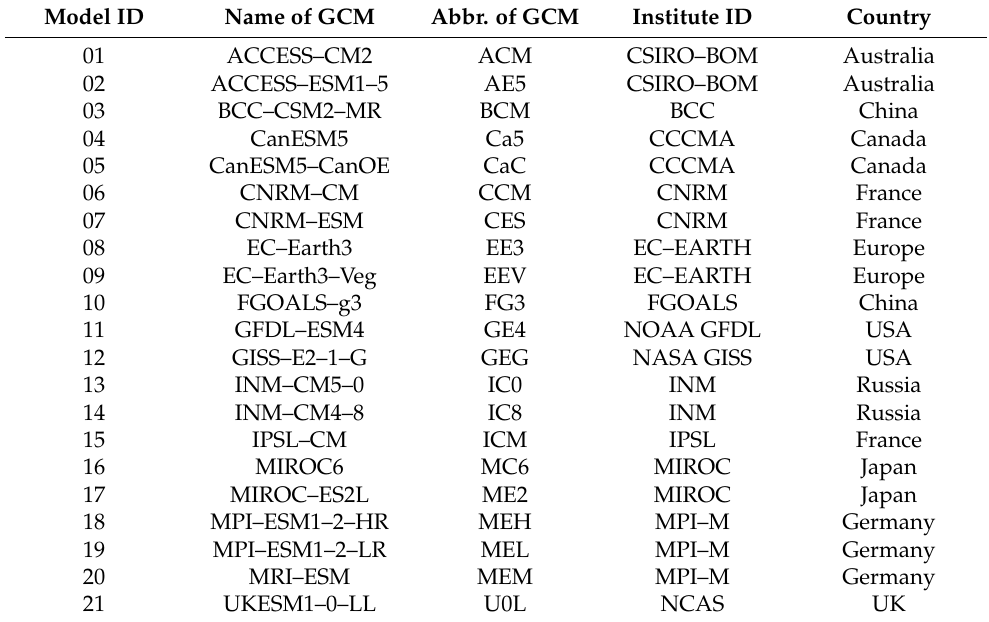
Table 5. List of 21 general circulation models (GCMs) under SSP245 and SSP585 future climate scenarios used in the study for statistical downscaling outputs of the Qiliying experimental station